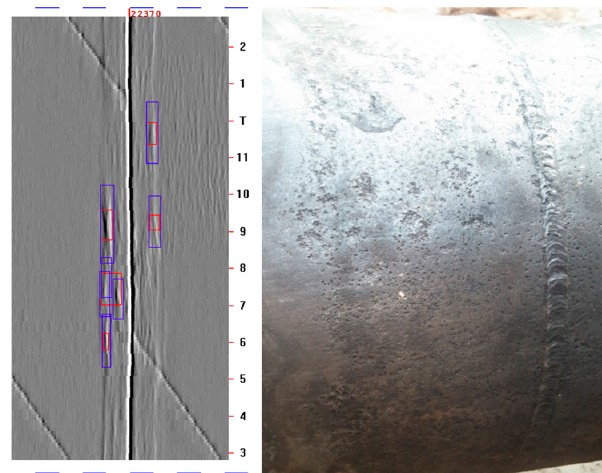
Figure 12. Typical signals and excavation pictures for type 2.